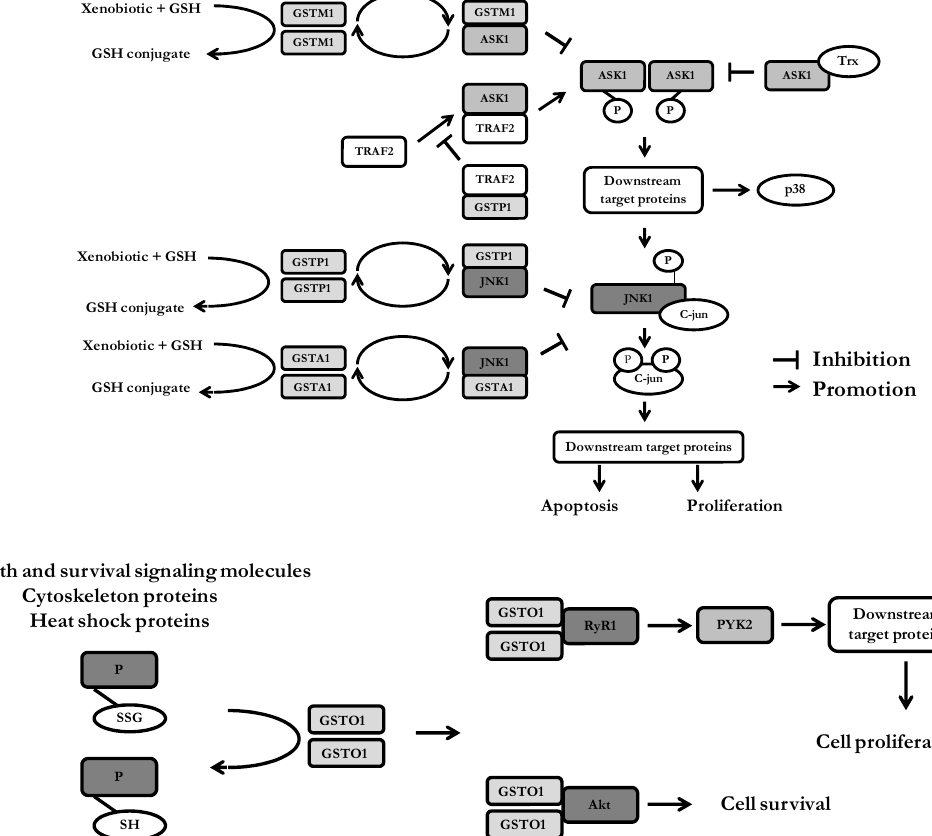
Figure 2. Dual functionality of GSTs in cancer: coexistence of catalytic and regulatory roles.